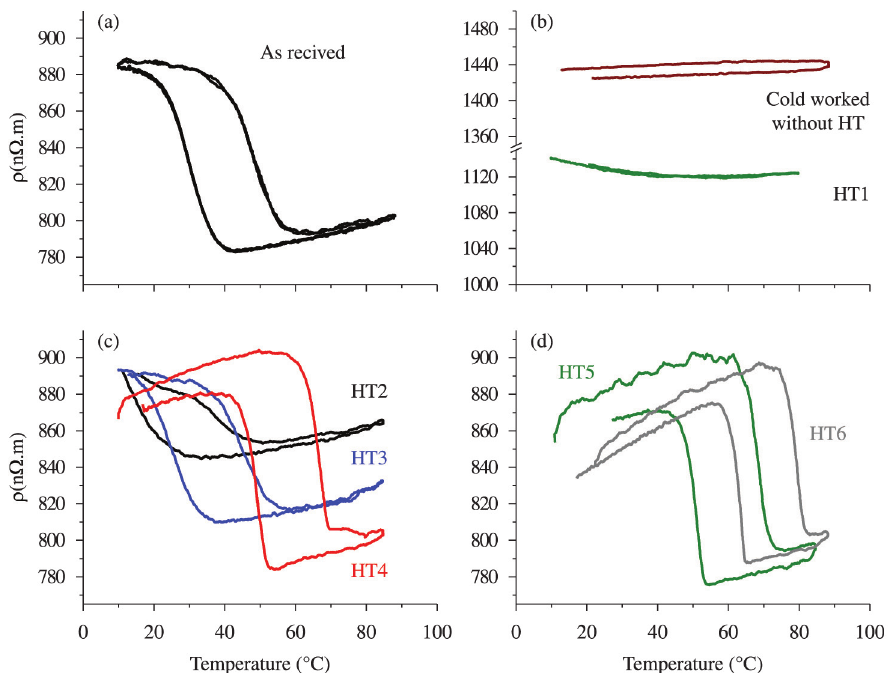
Figure 4. Electrical resistivity vs. Temperature for austenite and martensite